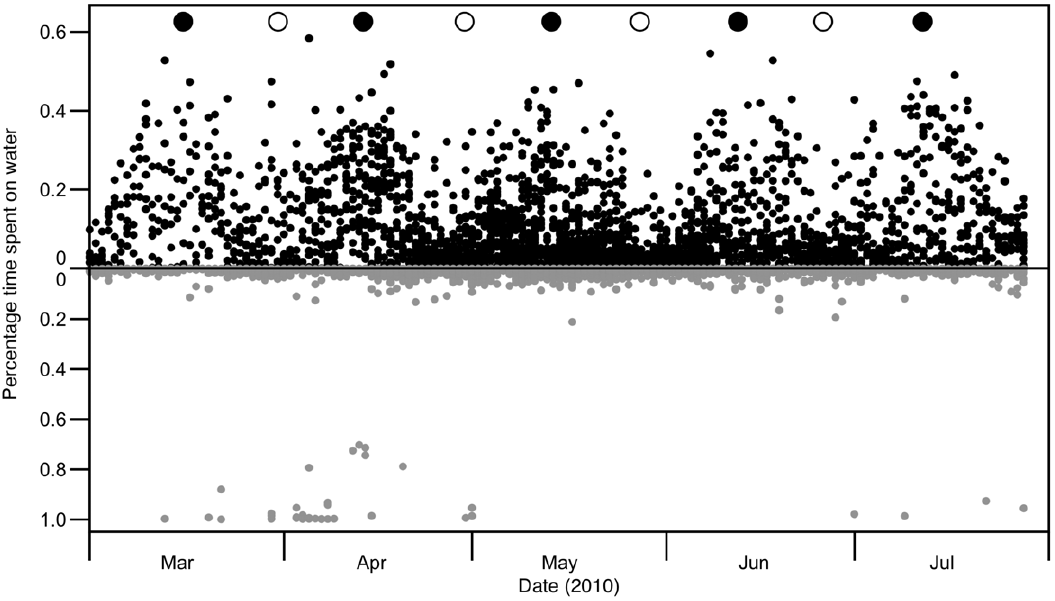
Figure 2. Percentage of time spent on the water by day (grey) and night (black) for 37 swallow-tailed gulls ( Creagrusfurcatus ) during the breeding period on Espan˜ola Island. Upper filled and unfilled circles represent new and full moons, respectively.